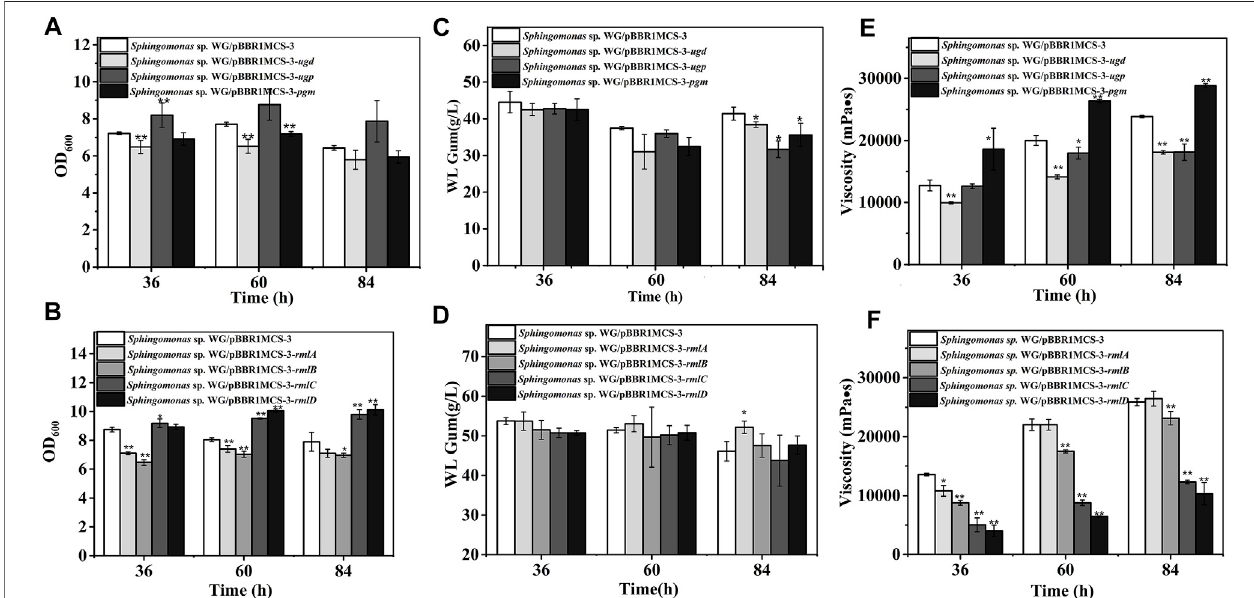
FIGURE 2 | Fermentation results of over-expression strains containing genes involved in nucleotide-sugar biosynthesis. (A) Comparison of biomass of Sphingomonas sp. WG/pBBR1MCS-3- pgm , Sphingomonas sp. WG/pBBR1MCS-3- ugp, and Sphingomonas sp. WG/pBBR1MCS-3- ugd . (B) Comparison of biomass of Sphingomonas sp. WG/pBBR1MCS-3- rmlA , Sphingomonas sp. WG/pBBR1MCS-3- rmlB, Sphingomonas sp. WG/pBBR1MCS-3- rmlC , and Sphingomonas sp. WG/pBBR1MCS-3- rmlD . (C) Comparison of WL gum production of Sphingomonas sp. WG/pBBR1MCS-3- pgm , Sphingomonas sp. WG/ pBBR1MCS-3- ugp, and Sphingomonas sp. WG/pBBR1MCS-3- ugd . (D) Comparison of WL gum production of Sphingomonas sp. WG/pBBR1MCS-3- rmlA , Sphingomonas sp. WG/pBBR1MCS-3- rmlB, Sphingomonas sp. WG/pBBR1MCS-3- rmlC , and Sphingomonas sp. WG/pBBR1MCS-3- rmlD . (E) Comparison of fermentation broth viscosity of Sphingomonas sp. WG/pBBR1MCS-3- pgm, Sphingomonas sp. WG/pBBR1MCS-3 -ugp, and Sphingomonas sp. WG/pBBR1MCS-3 - ugd . (F) Comparison of fermentation broth viscosity of Sphingomonas sp. WG/pBBR1MCS-3- rmlA , Sphingomonas sp. WG/pBBR1MCS-3- rmlB, Sphingomonas sp. WG/pBBR1MCS-3- rmlC , and Sphingomonas sp. WG/pBBR1MCS-3- rmlD . The fermentation was preformed in 250 ml shaking fl asks containing 50 ml fermentation medium (67 g/L Glc, 3.4 g/L yeast extract, 0.1 g/L MgSO 4 , 3 g/L K 2 HPO 4 , pH 7.0), and cultured at 32 ° C, 150 rpm for 36, 60 and 84 h. The strain Sphingomonas sp. WG/pBBR1MCS-3 was used as the